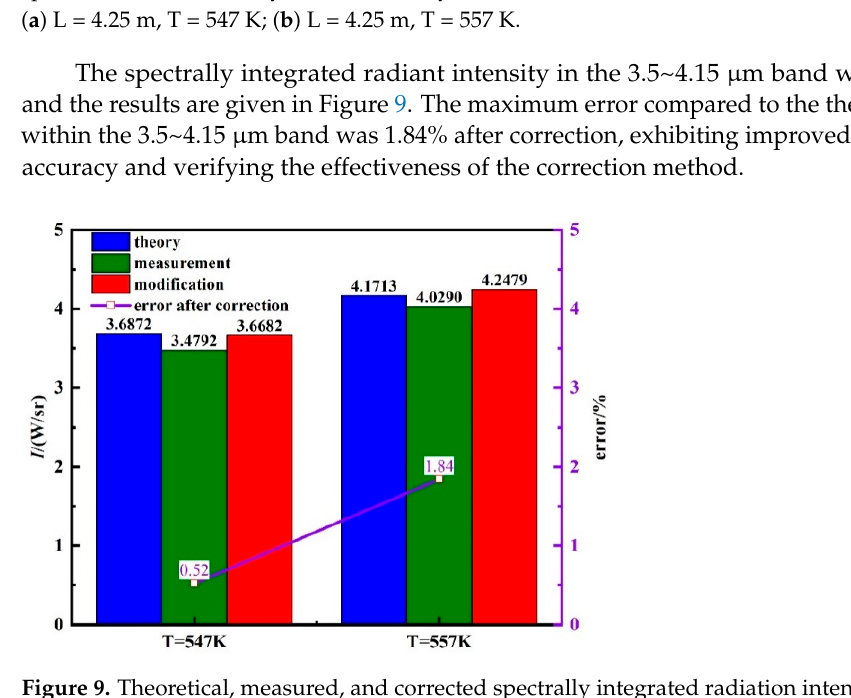
Figure 9. Theoretical, measured, and corrected spectrally integrated radiation intensity values and corrected errors in the 3.5~4.15 µ m band.